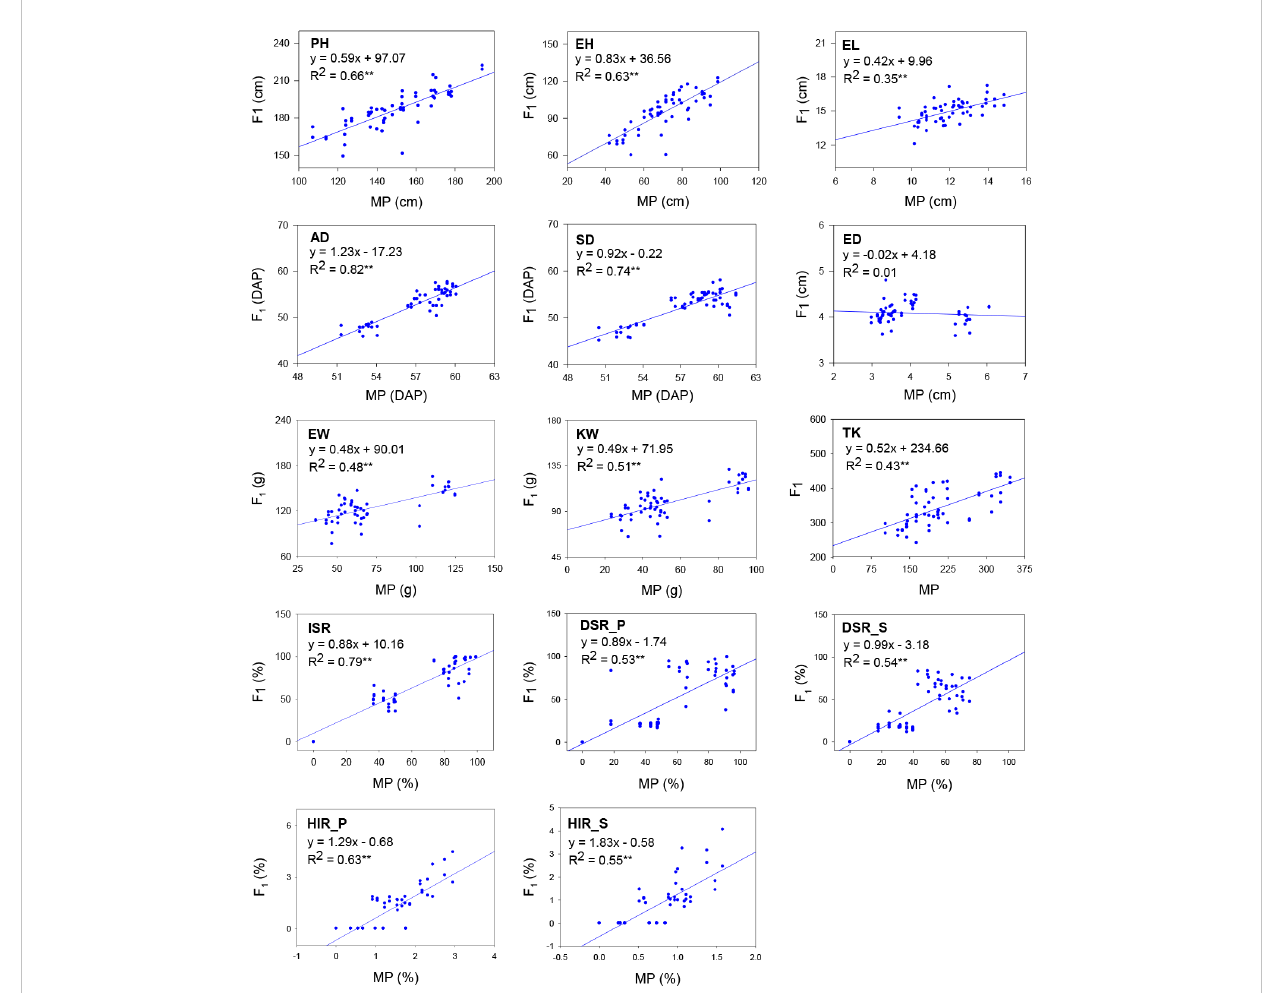
FIGURE 2 Linear regression between mid-parent (MP) and hybrid performance (F 1 ) of 56 crosses evaluated across two seasons. PH, plant height; EH, ear height; AD, anthesis date; SD, silking date; EL, ear length; ED, ear diameter; EW, ear weight; KW, total kernel weight per ear; TK, total kernel number per ear; ISR, the R1-nj seed set of inducers; DSR_P, the R1-nj seed set with donor P789; DSR_S, the R1-nj seed set with donor S7328; HIR_P, haploid induction rate with donor P789; HIR_S, haploid induction rate with donor S7328. R 2 coef fi cient of determination. ** signi fi cant at p ≤